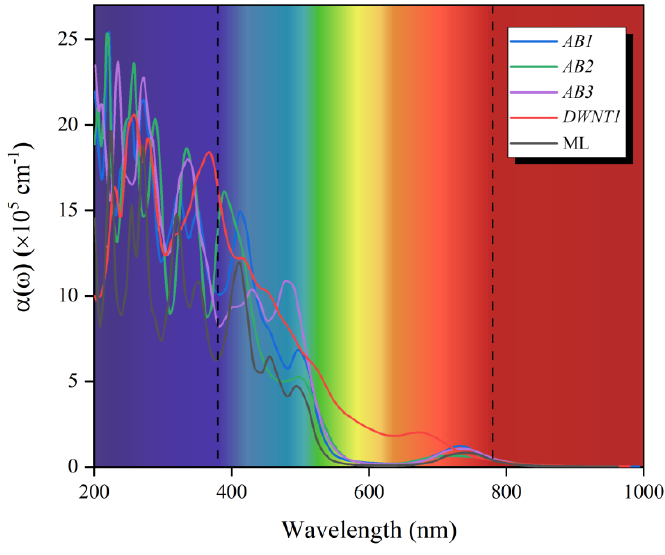
Figure 4. Optical absorption coefficients α ( ω ) for the WSSe ML, WSSe bilayer with different stacking patterns ( AB1 , AB2 , and AB3 ), and WSSe DWNT1 .